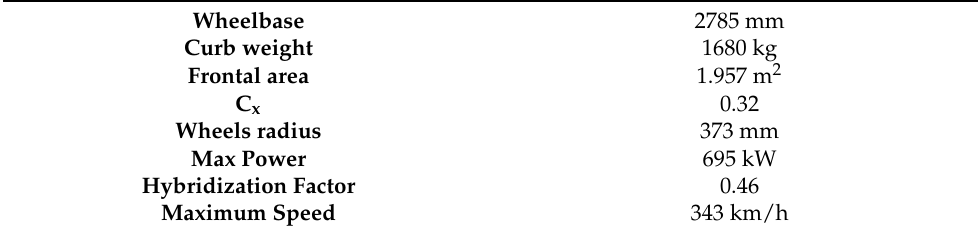
Table 2. Main specifications of the vehicle.